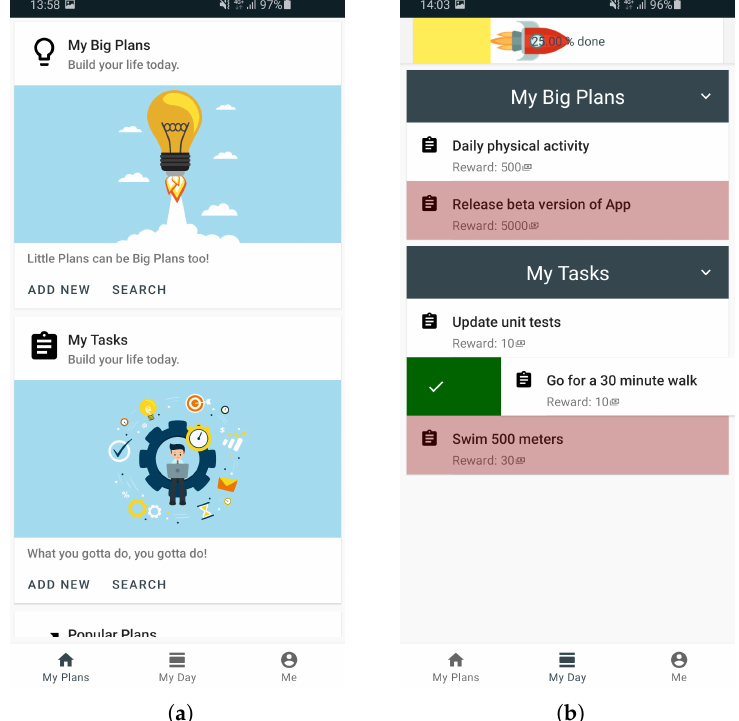
Figure 1. Core screens of our mobile application: ( a ) the landing page; ( b ) overview of specific Big Plans that contain separate tasks; a user assigns a reward to each task, sets a deadline, and can mark tasks as